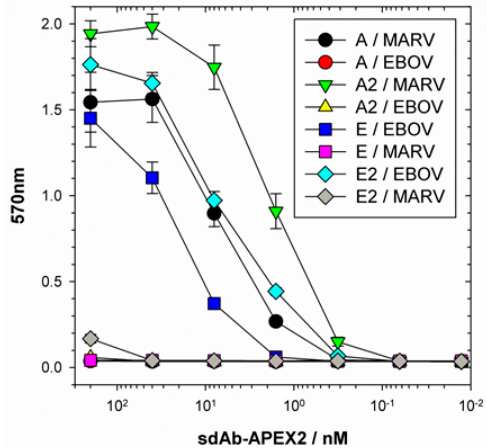
Figure 5. ELISA titration of sdAb–APEX2 monomers (A and E) or dimers (A2 and E2) over purified recombinant MARV or EBOV NP using Amplex® UltraRed substrate and colorimetric recording. Curves represent an n of 2 with error bars +/ − SD.